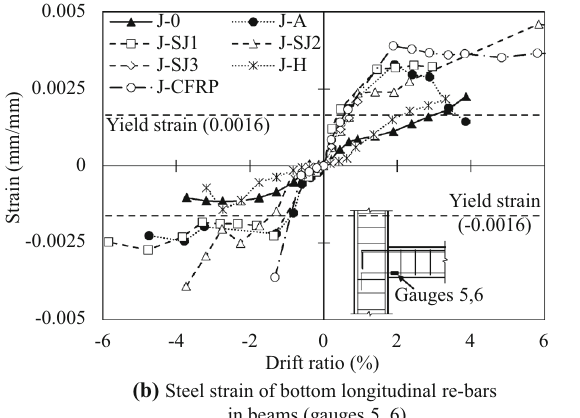
(a) Steel strain of top longitudinal re-bars in beams (gauges 3, 4)